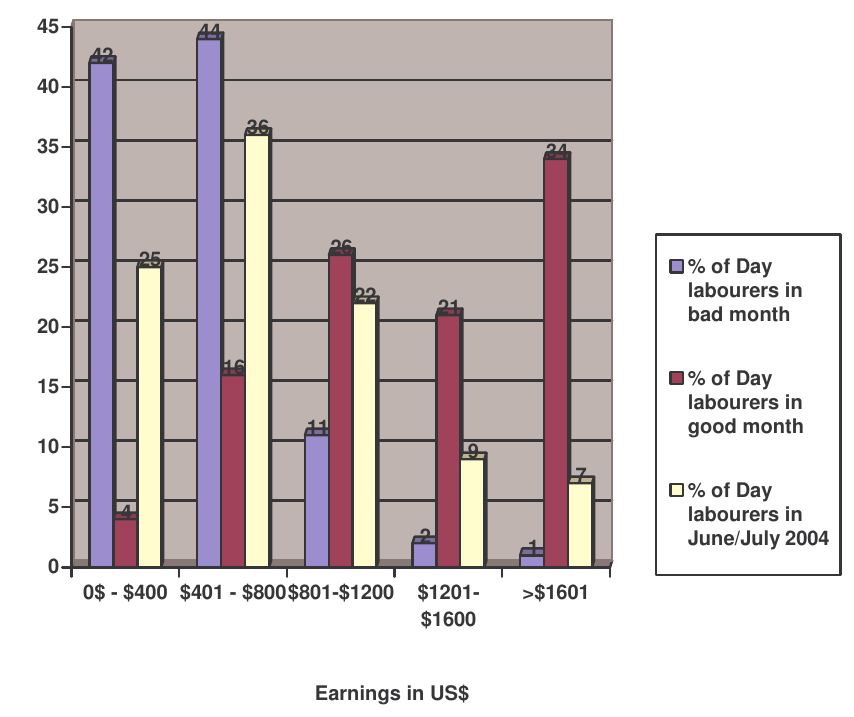
Figure 6: monthly earnings of day labourers in the United States in June/July 2004, a good month and a bad month